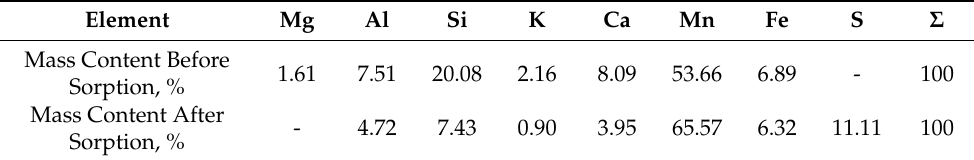
H 2 S, obtained by the X-ray fluorescence analysis method (Table 3), indicate a significant increase in the sulfur content in the ore, and, as a consequence, a decrease in the relative content of manganese, iron and other elements. Table 3. Chemical composition of the ore after sorption of hydrogen sulfide (relative percentages). Element MnO Content, %